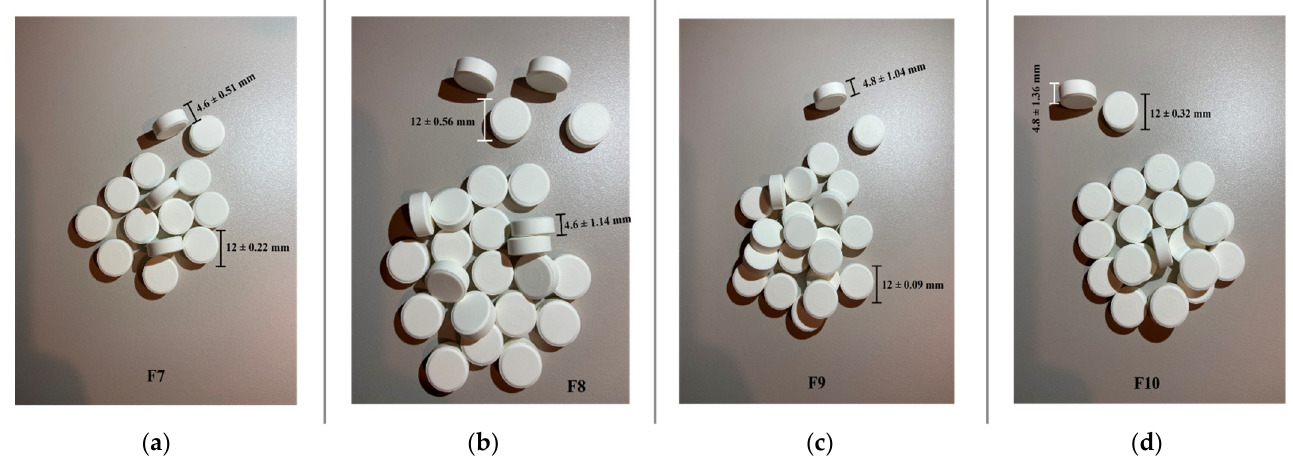
Figure 14. The general appearance of the four tablet formulations ( a ) — F7, ( b ) — F8, ( c ) — F9, ( d ) —